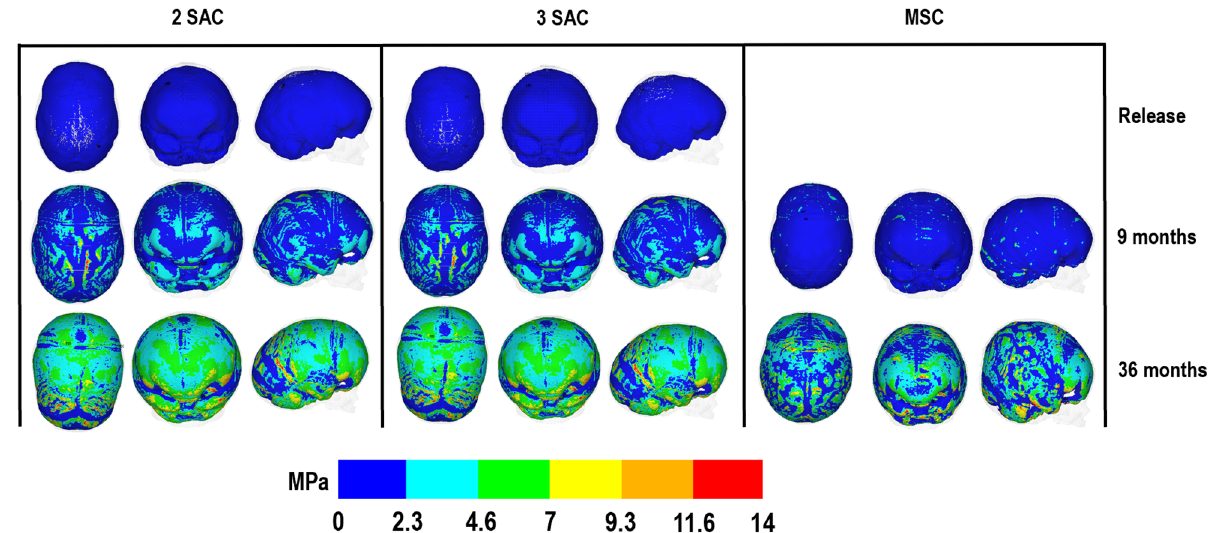
Figure 7. ICV pressure predictions across ICV-bone surface for all